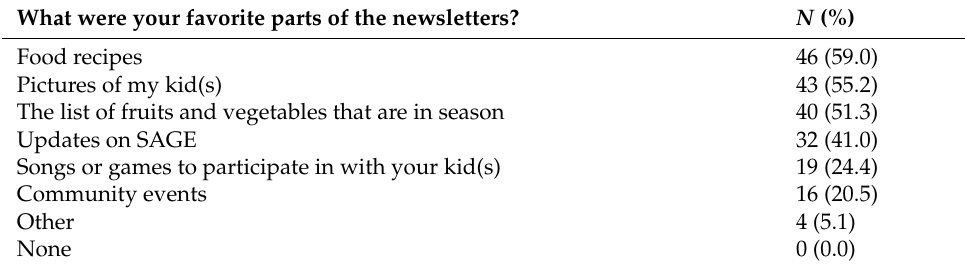
Table 5. Favorite Aspects of Newsletters and Participation ( N =